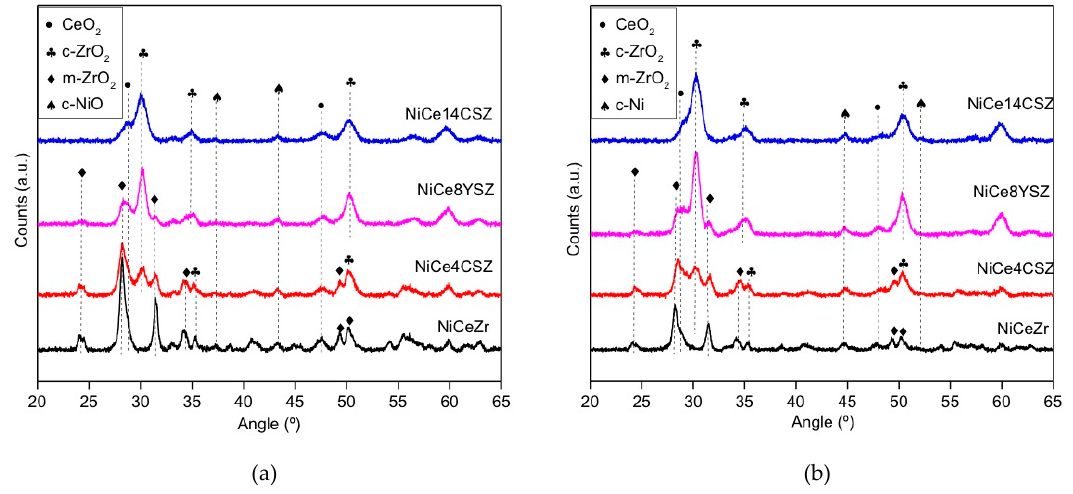
Figure 2. XRD patterns of the investigated catalysts (with Ce): ( a ) calcined; ( b ) reduced.